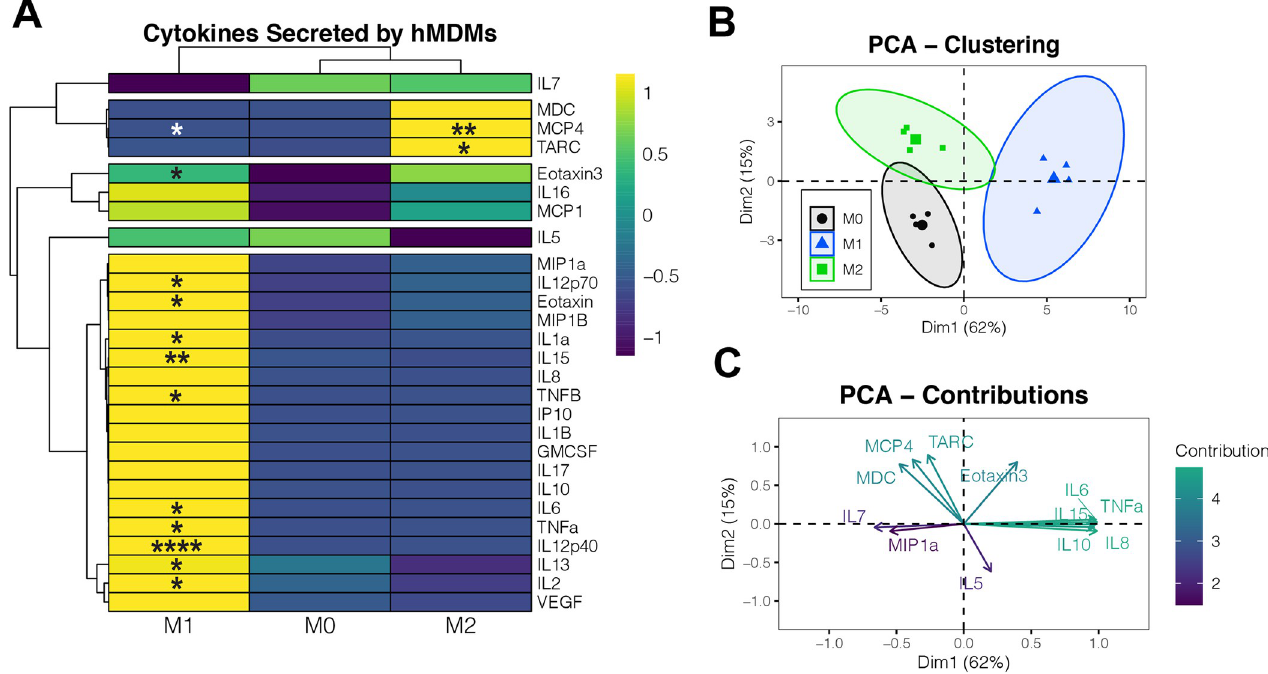
Fig 4. Expanded characterization of cytokines, chemokines, and soluble mediators expressed by hMDM. (A) Row-scaled heatmap showing protein expression. � p < 0.05, �� p < 0.01, ���� p < 0.0001 in comparison with M0 hMDMs by either matched one-way ANOVA with Tukey’s multiple comparisons test or Friedman test with Dunn’s multiple comparisons test. Raw concentrations and significant comparisons between M1 and M2 hMDMs are reported in S2 Table. (B) PCA plot showing clustering of cytokine secretion by polarized hMDMs. (C) Percentage contributions of each variable to the variation observed in the first two PCA dimensions. For all plots, n = 4 biological replicates (1 male, 3 females) with one technical replicate per biological replicate and polarization state.